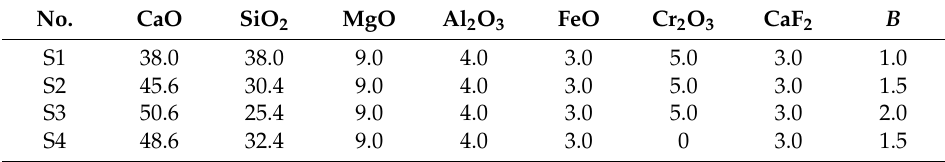
Table 1. Chemical composition of the target stainless steel slag, wt % and index of basicity, B .